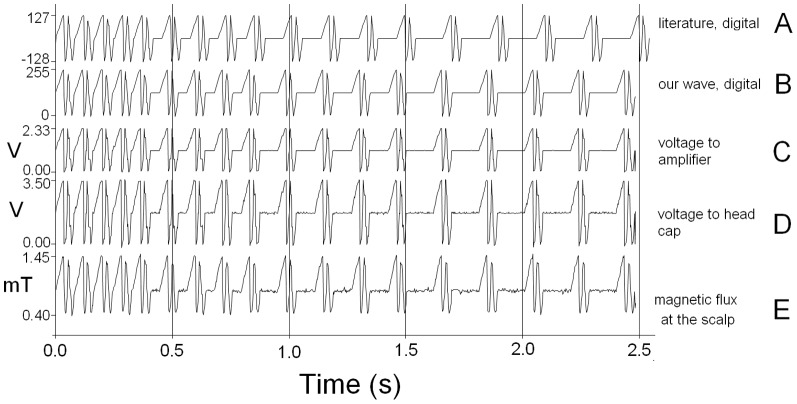
Different stages of the CNP signal.The digital version of the CNP wave as published in the literature[22] (A) and used here (B), was converted by PC and interface card to the analogue version (C), which was amplified (D) and converted to a magnetic wave (E), all to the same time scale.